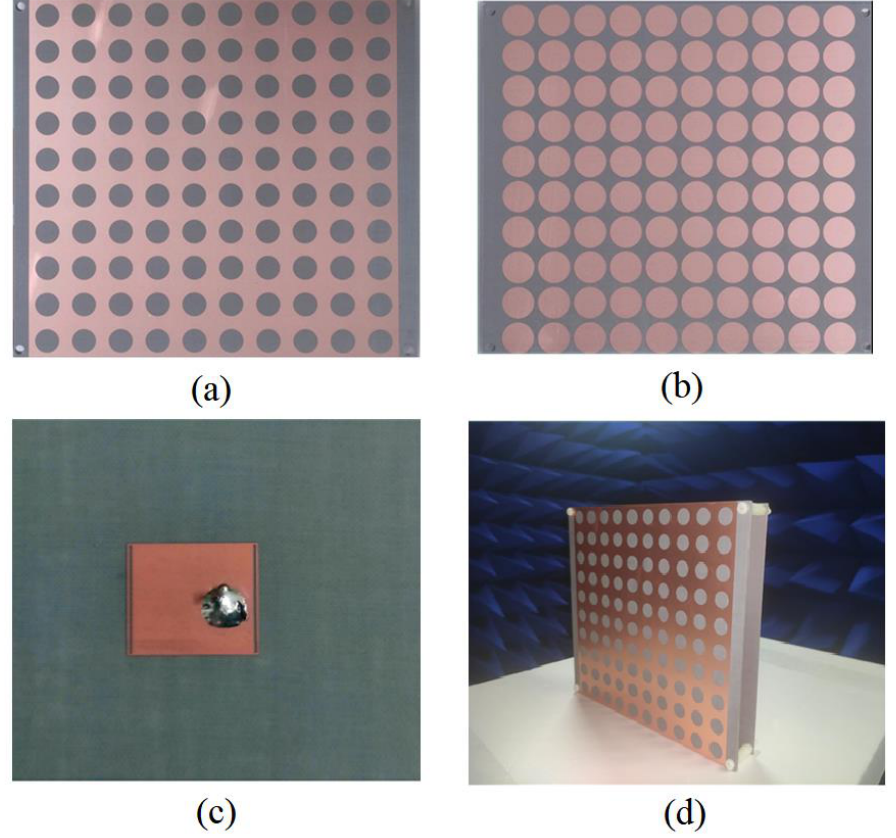
Figure 11. Photos of the metamaterial antenna: ( a ) the top view of the dual-band AMC plate; ( b ) the bottom view of the dual-band AMC plate; ( c ) feed patch antenna; ( d ) the metamaterial antenna placed in the microwave antrum.